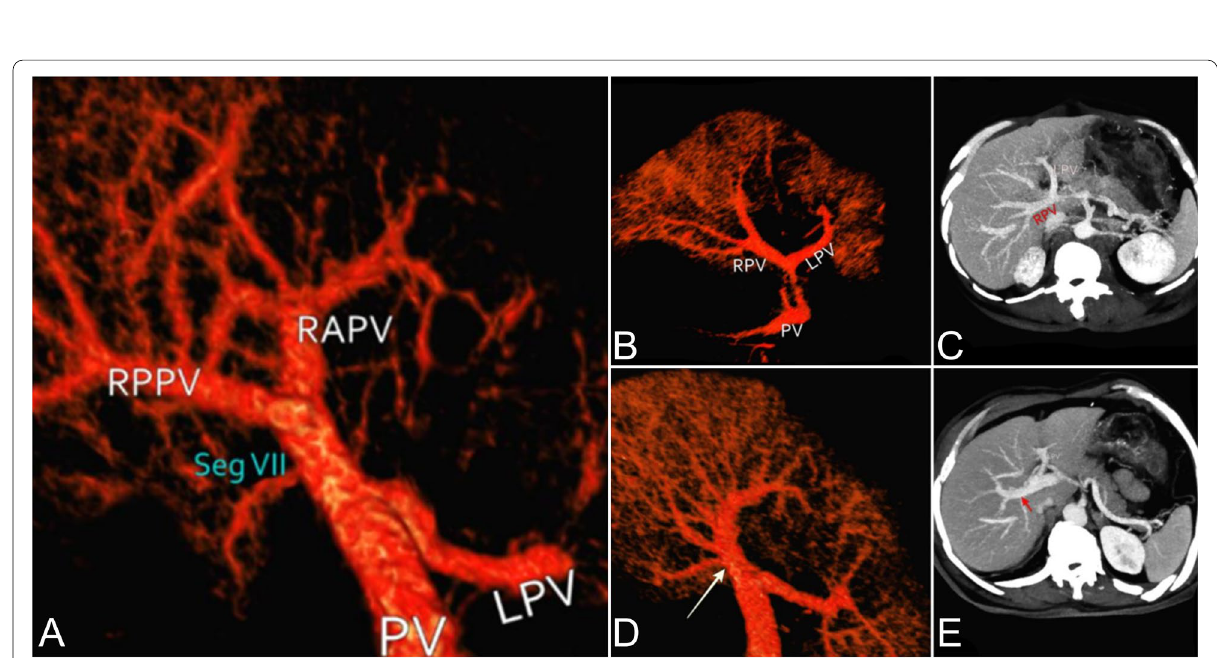
Fig. 5 Rare portal vein anatomical variants found in the study. A Early separate origin of the segment 7 branch from Right portal vein (RPV). B and C Trifurcation of RPV. D and E Non-bifurcation of the RPV with small segmental branches to right lobe (arrows). ( A , B , D - 3-dimensional reconstructions of contrast enhanced CTs. C , E - Maximum intensity projections of contrast enhanced